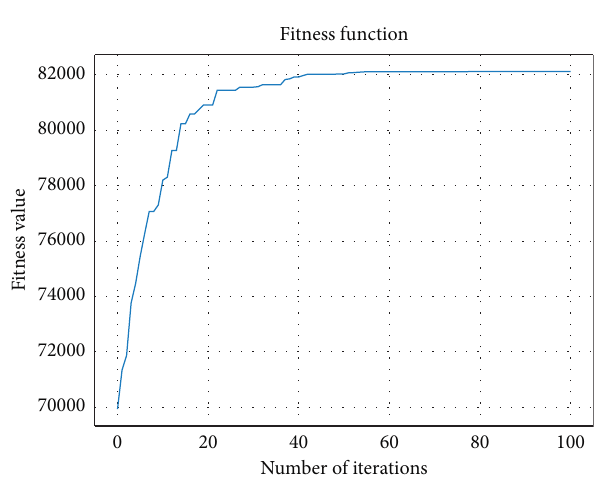
Figure 9: Fitness value iteration.